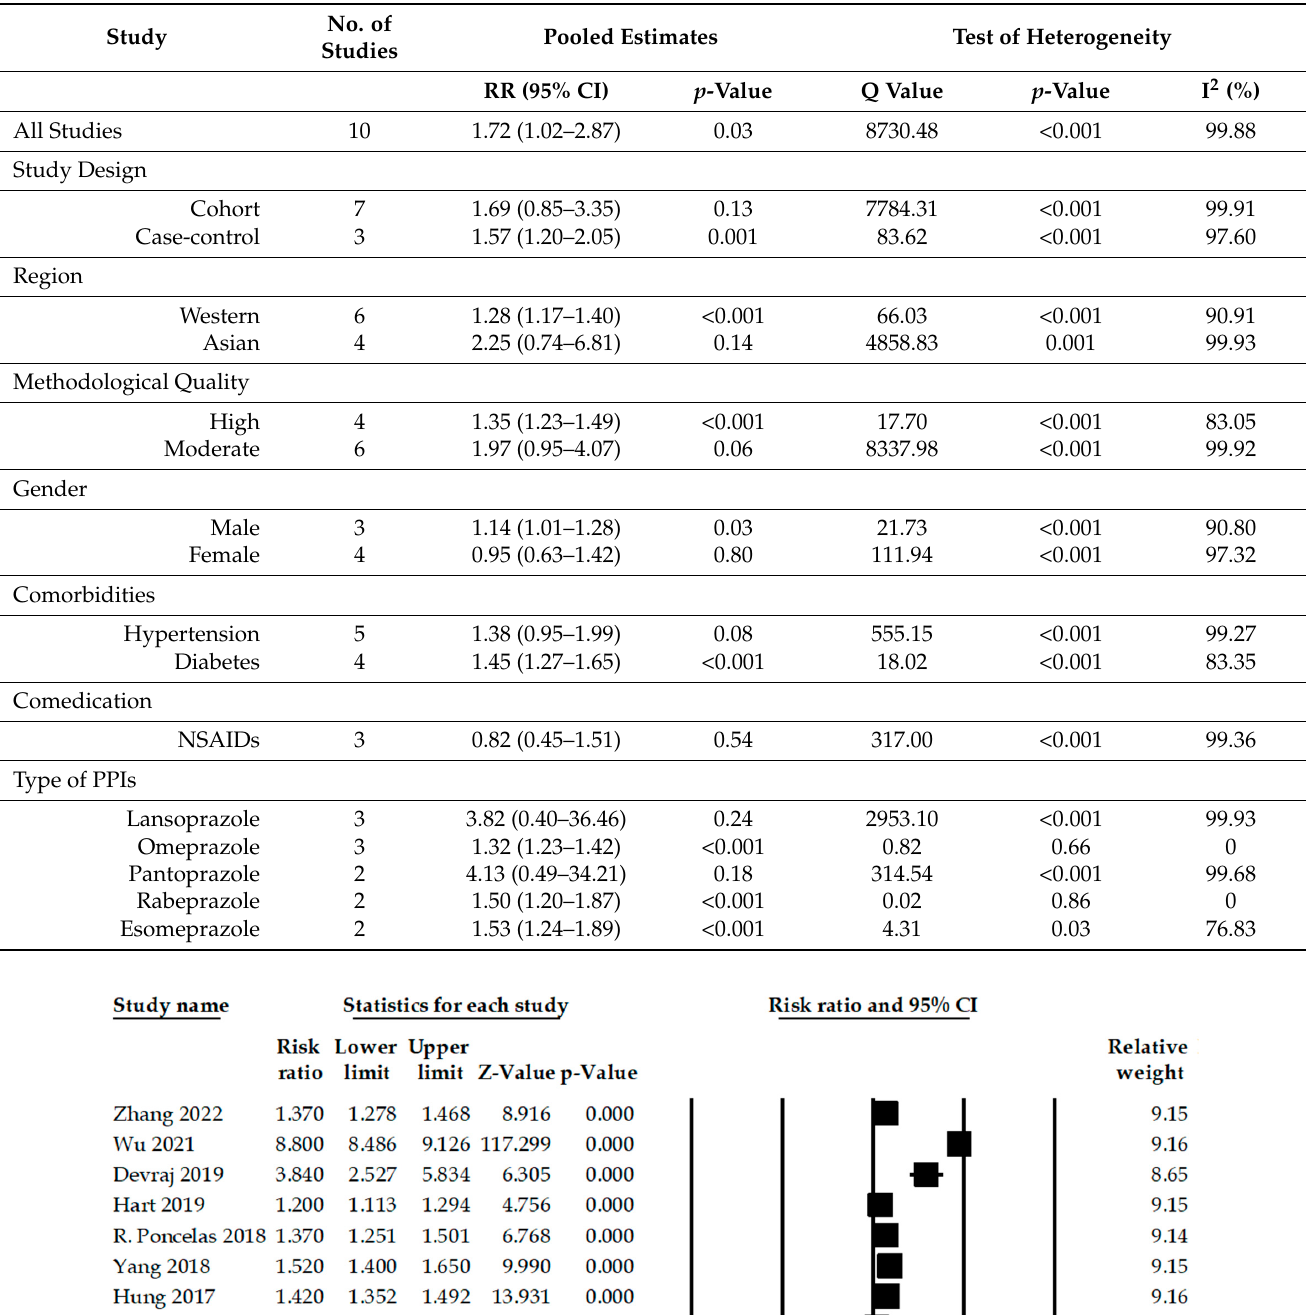
Table 2. Subgroup analysis for the association between PPI and CKD.